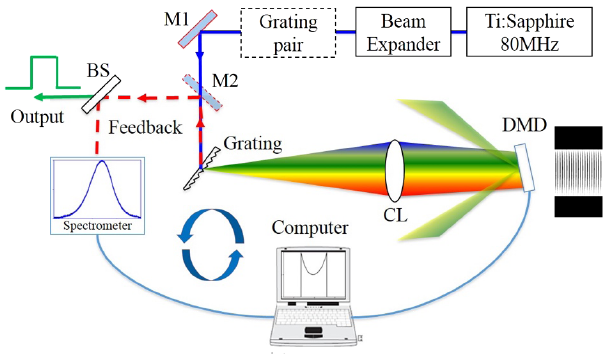
Fig. 1. Experimental setup of the DUPS. M1-M2: high- re°ection mirrors; BS: beam splitter; CL: cylindrical lens; DMD: digital micromirror